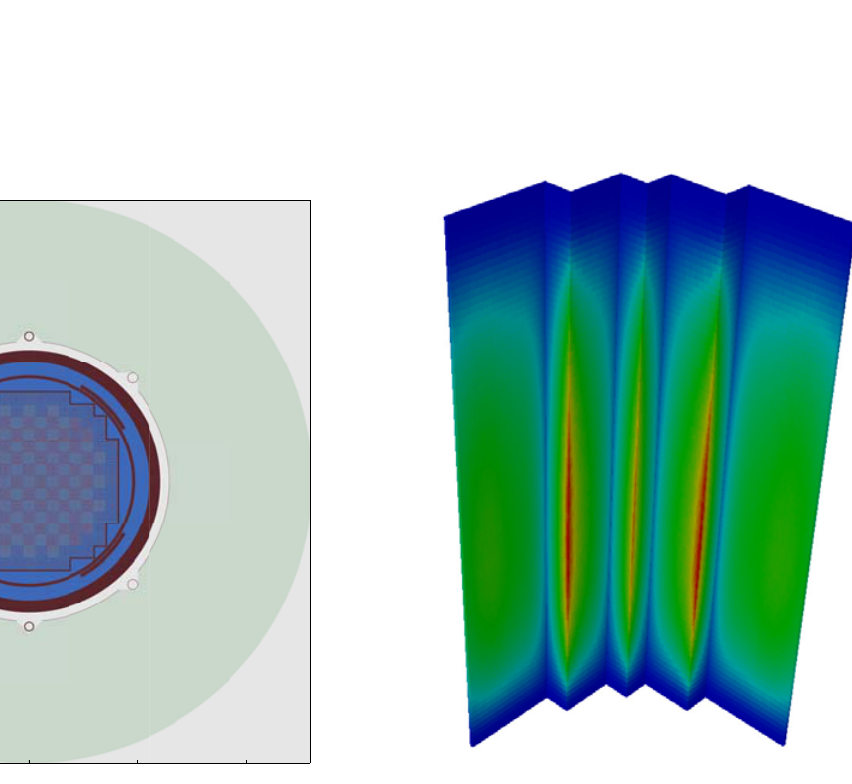
Figure 4: Visualization of baffle tally results in the northeast quadrant of WBN1.